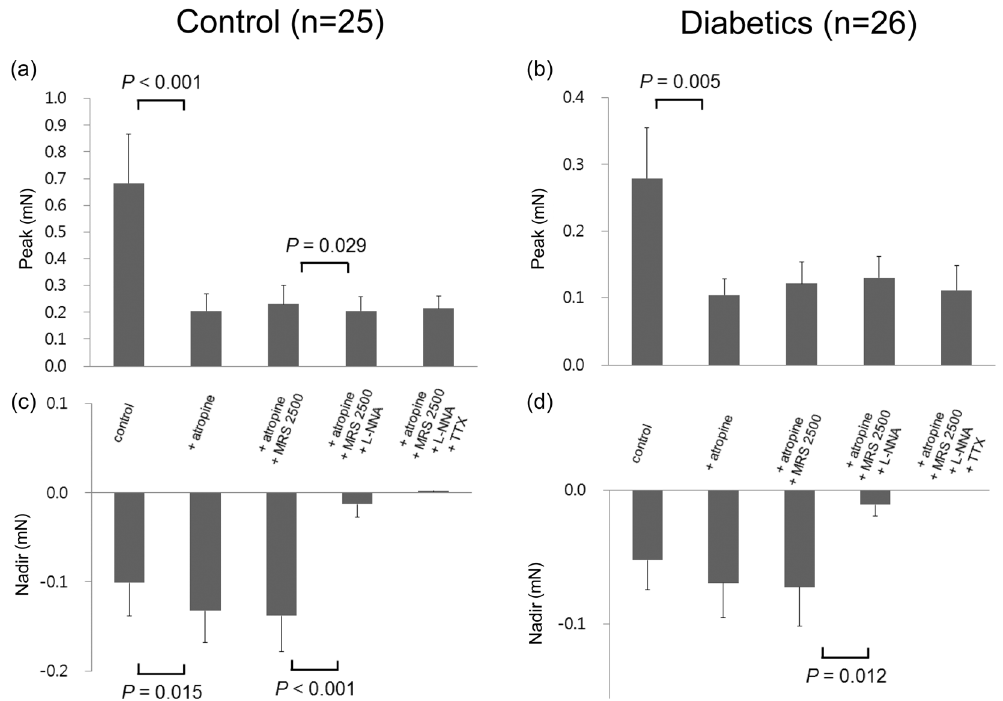
Figure 6. Electrical field stimulation (EFS)-induced response of distal gastric longitudinal muscle strips after serial administration of atropine, MRS2500, N-nitro-L-arginine (L-NNA), and tetrodotoxin (TTX). ( a ) Atropine and L-NNA decreased the peak in the control subjects. ( b ) Atropine decreased the peak in the diabetic patients. ( c ) Atropine increased the nadir but L-NNA abolished relaxation in the control subjects. ( d ) Also in diabetic patients, L-NNA abolished relaxation. The Wilcoxon signed-rank test was used to evaluate the effects of each drug by compare values to the previous